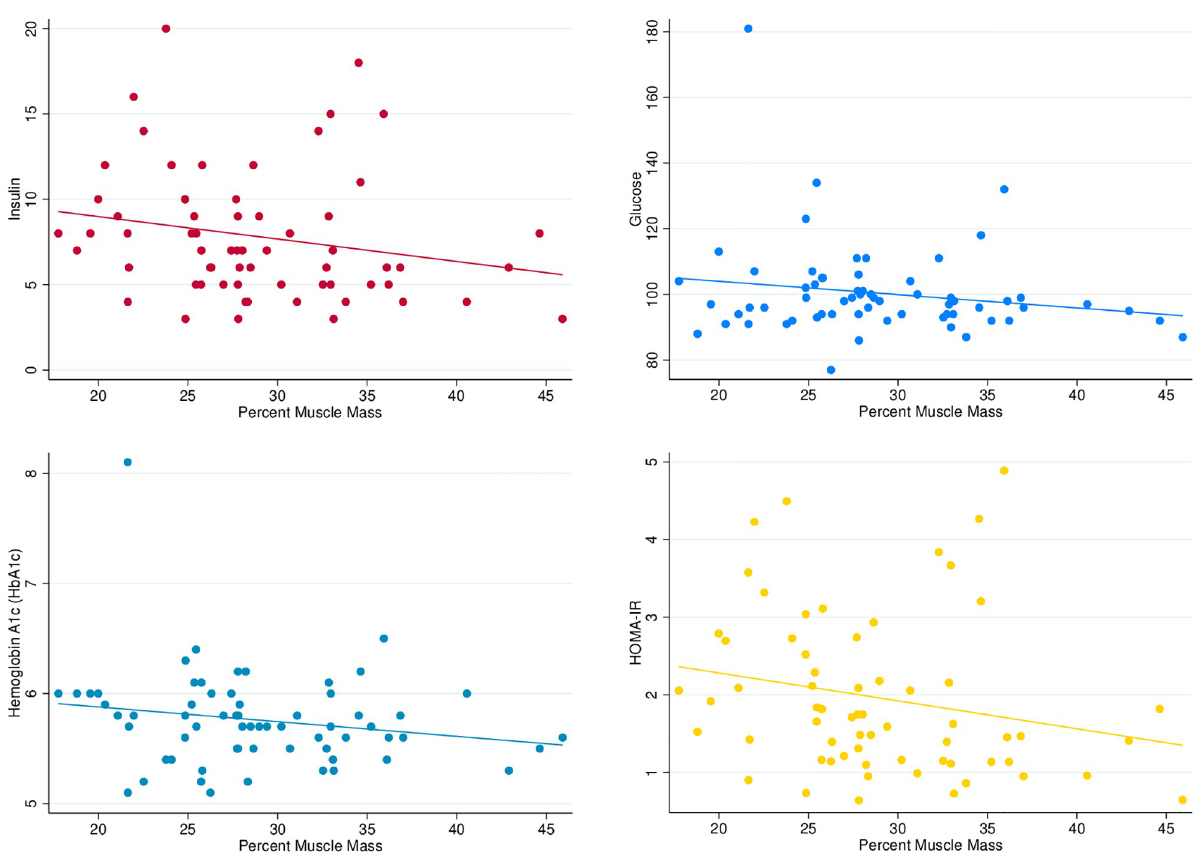
Fig 3. Scatterplots describing the association between indices of insulin-glucose homeostasis and percent muscle mass.